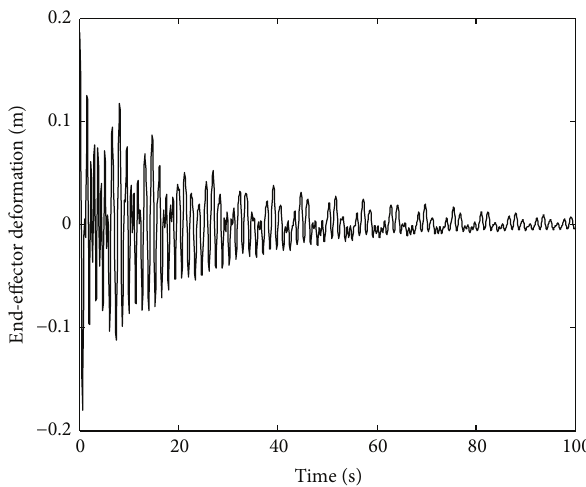
Figure 16: Response of the controlled arm ( 𝑟 = 0 . 75